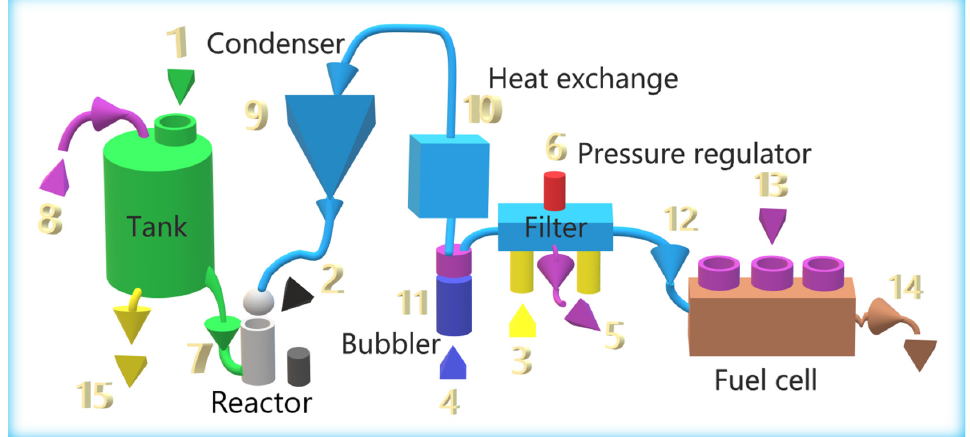
Figure 3. Parts of the hydrogen- and electricity-generation system of the electric bicycle.